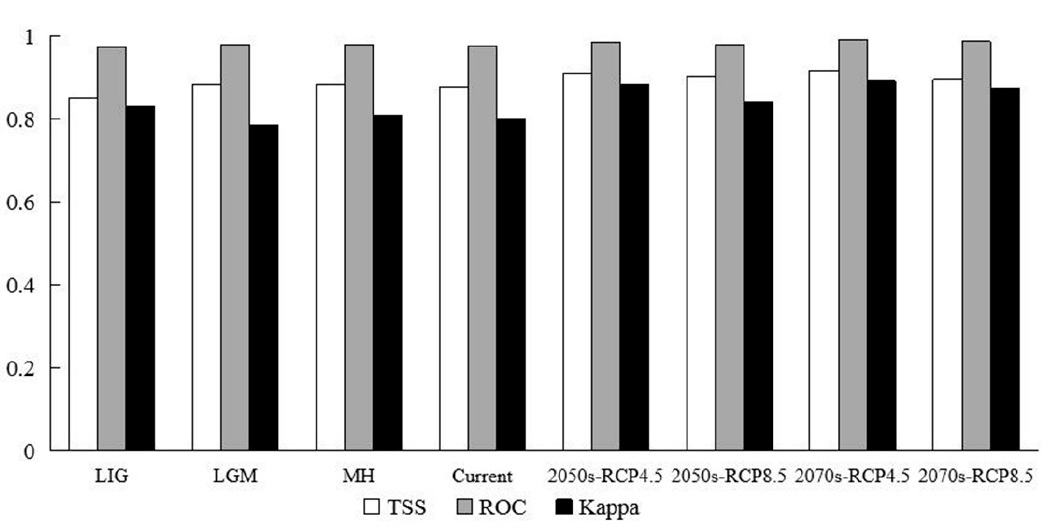
Figure 2. Evaluation indexes of our model under eight climate scenarios. LIG represents the Last Interglacial, LGM represents the Last Glacial Maximum, MH represents the Mid-Holocene, Current represents the current scenarios, 2050s-RCP4.5 represents the RCP4.5 in the 2050s, 2050s-RCP8.5 represents the RCP8.5 in the 2050s, 2070s-RCP4.5 represents the RCP 4.5 in the 2070s, and 2070s-RCP8.5 represents the RCP 8.5 in the 2070s, respectively.